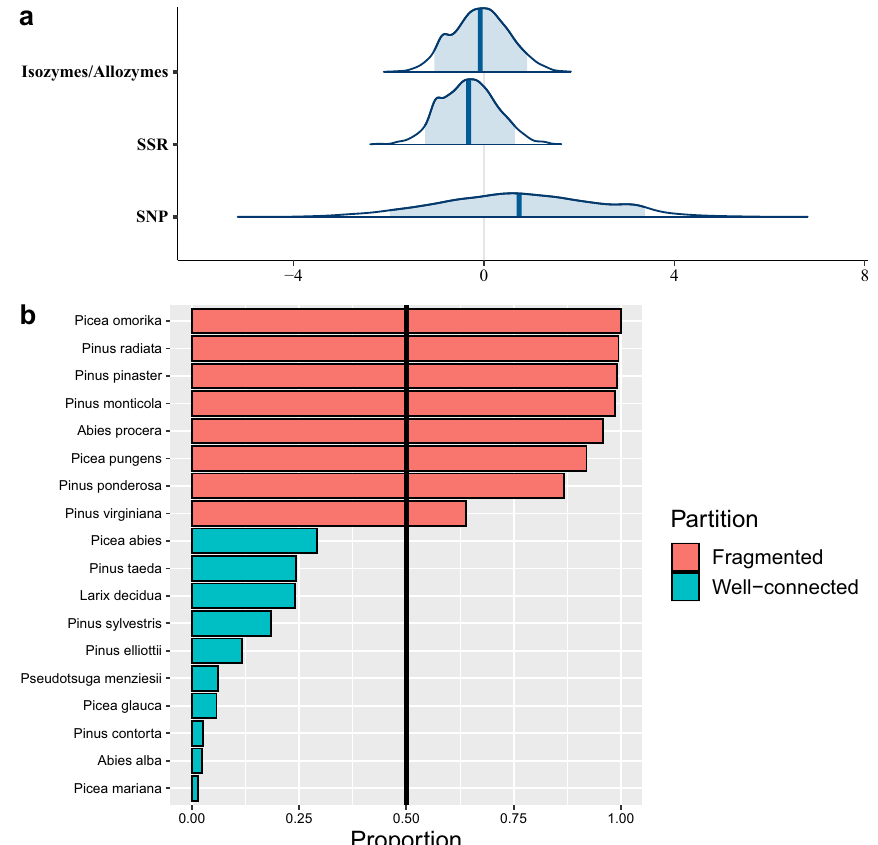
Figure 3. The results of the beta-regression and clustering of the Pinaceae species into fragmented or well- connected groups, with: ( a ) inferred posterior distributions of marker types with 90% CI highlighted in blue, and ( b ) model 2 approach to partition the species into two groups, where the Serbian spruce was fixed in the patchy partition (because of the highest average F st ) to avoid label switching problems.